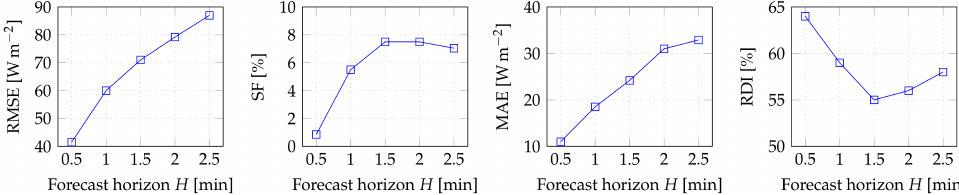
Figure 14. Image-based model results: RMSE, SF, MAE, and RDI as a function of the forecast horizon H (test